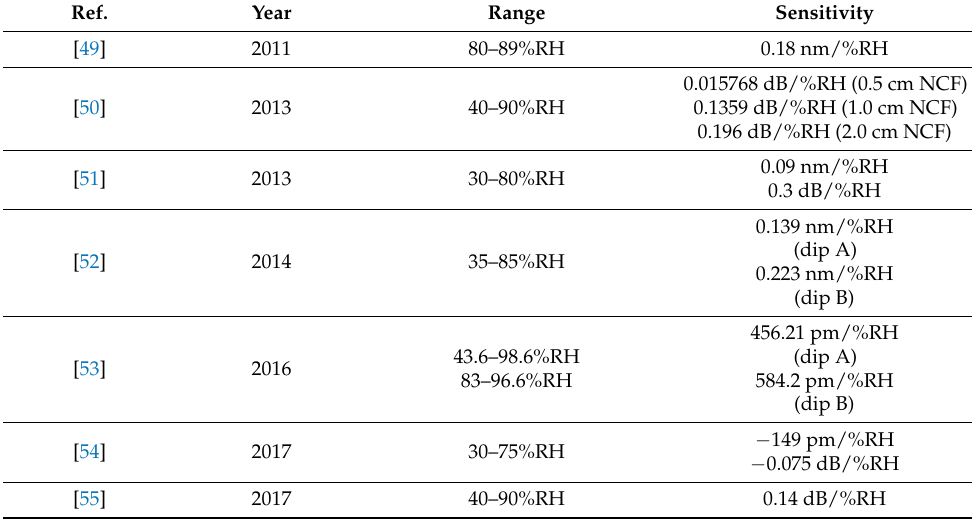
Table 3. Summary of the relevant parameters of MMI relative humidity